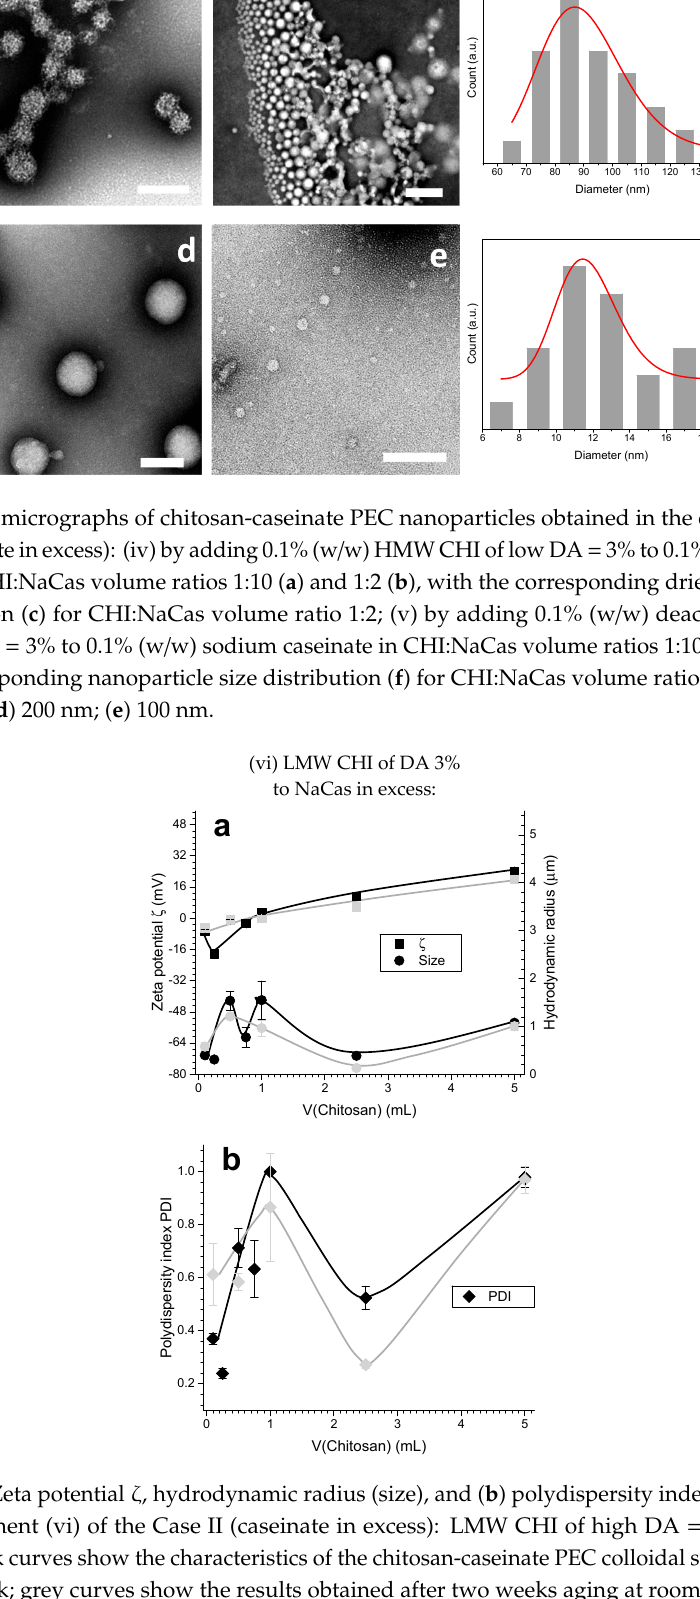
Figure 11. TEM micrographs of of chitosan-caseinate PEC nanoparticles obtained in the experiment (vi) of Case II (caseinate in excess) by adding 0.1% (w/w) solution of LMW CHI with DA = 13% to 0.1% (w/w) sodium caseinate in CHI:NaCas volume ratios of 1:10 ( a ) and 1:2 ( b ), with the corresponding dried nanoparticles size distribution ( c ) for CHI:NaCas volume ratio 1:2. Scale bars: (a; b) 200 nm. 2.4. Insulin Delivery Chitosan-Caseinate Nanoparticle Systems. Insulin Entrapment Efficiency and Release To prepare insulin entrapped chitosan–caseinate nanoparticles, two approaches were considered. In Model I, the insulin was hypothesized to first bind to the chitosan to constitute a loaded particle shell, with the caseinate located in the nanoparticle core region (Scheme 1-I). In Model II the insulin was firstly put in interaction with the sodium caseinate solution, which mixture was then expected to be surrounded by a chitosan shell (Scheme 1-II). In both approaches, the chitosan of high molecular weight and low DA (HMW CHI) was used, and experiments corresponding to Case II (chitosan solution added to NaCas in excess) were considered.